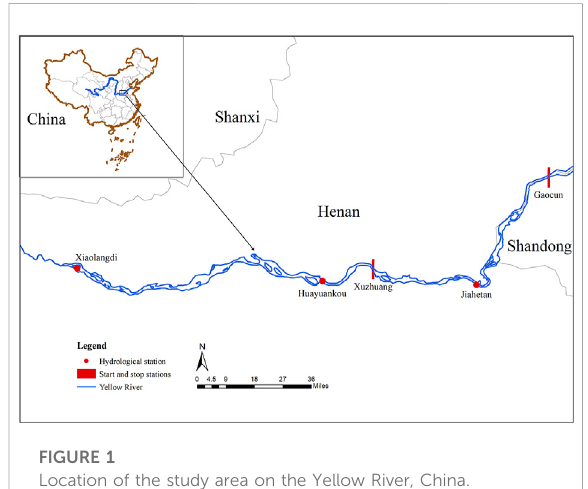
FIGURE 1 Location of the study area on the Yellow River, China.